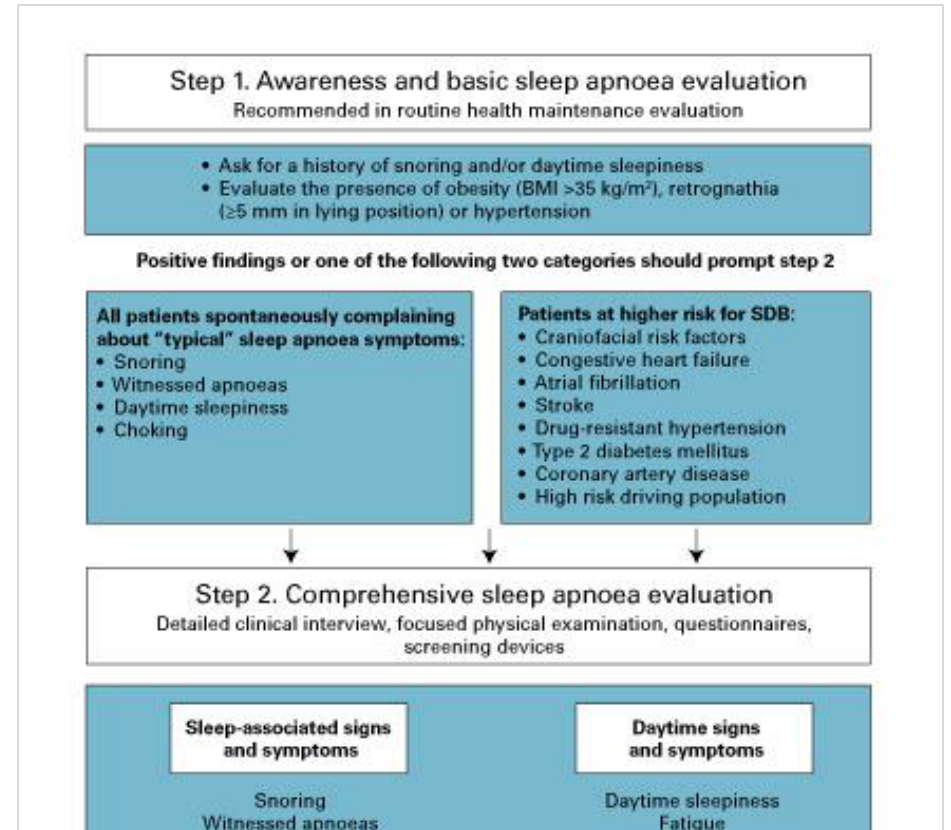
Figure 2: Sugges- tion for a simple three-step algo- rithm for the evalu- ation of sleep-disor- dered breathing (SDB). BMI = body mass in- dex; MSLT = multi- ple sleep latency test; MWT = maintenance of wakefulness text; OSA = obstructive sleep